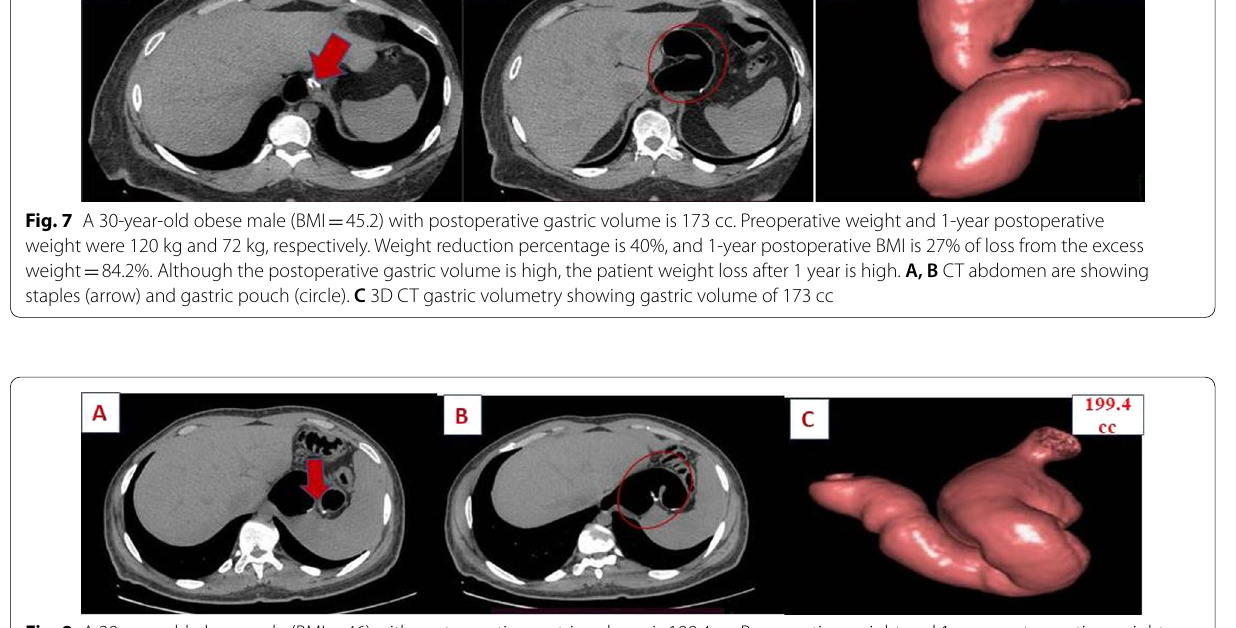
Fig. 8 A 29‑year‑old obese male (BMI 46) with postoperative gastric volume is 199.4 cc. Preoperative weight and 1‑year postoperative weight = were 133 kg and 83 kg, respectively. Weight reduction percentage is 37.6%, and 1‑year postoperative BMI is 28.7. % of loss from the excess weight 79.3%. Although the postoperative gastric volume is high, the patient weight loss after 1 year is high. A, B CT abdomen are showing = staples (arrow) and gastric pouch (circle). C 3D CT gastric volumetry showing gastric volume of 199.4